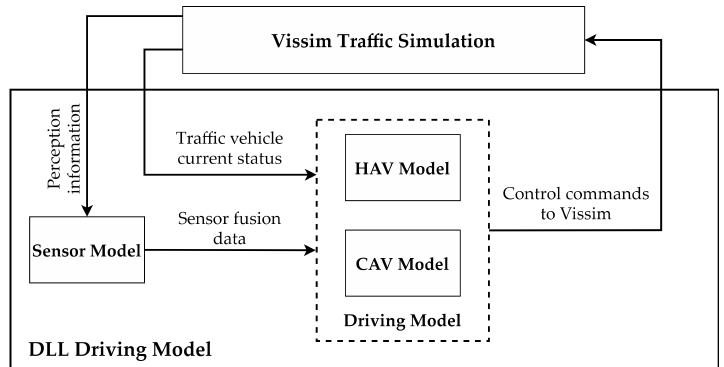
Figure 1. Overview of the DLL driving